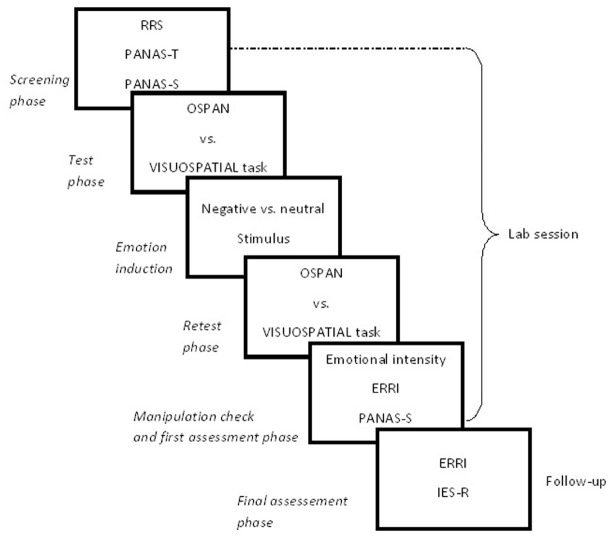
Flowchart of the procedure, measures, and materials employed in Experiment 1 and 2. The procedure for both experiments included: (1) a screening phase in which participants completed RRS, PANAS-T, and PANAS-S; (2) a test phase on WM capacity in which participants completed either the OSPAN or a Visuospatial analog task; (3) an emotion induction phase in which either a narrative excerpt (Experiment 1) or a video clip (Experiment 2) was administered to participants; (4) a re-test phase on participants’ WM capacity (OSPAN vs. Visuospatial task); (5) a manipulation check and first assessment phase in which participants answered questions concerning their emotional experience, ERRI and PANAS-S; and (6) a final assessment after 24 h in which a new ERRI and IES-R were administered to participants.